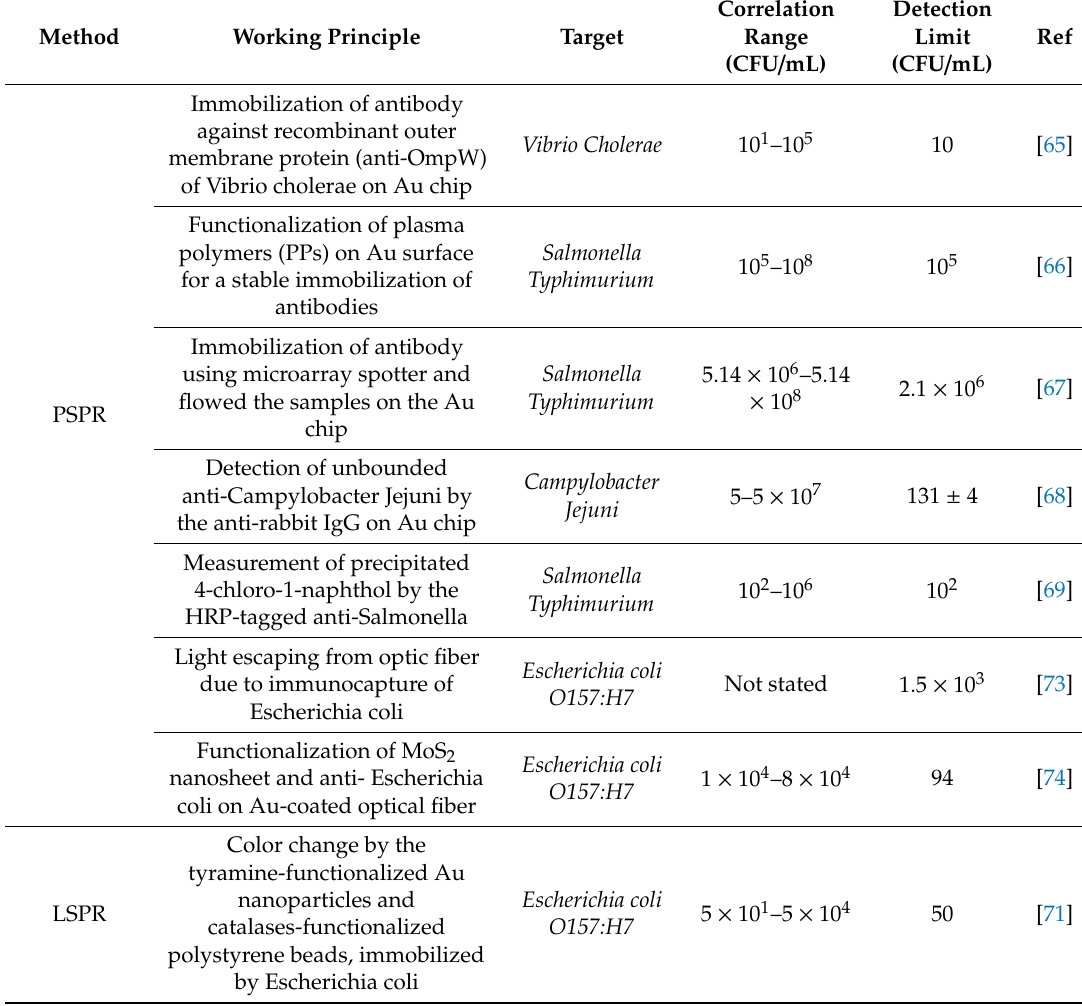
Figure 6. LSPR and optic fiber mediated SPR-based immunosensors for pathogenic microbe detection. ( a ) Colorimetric immunosensors with microfluidic device for the detection of E. coli O157 by aggregation of Au nanoparticles; ( b ) fiber optic SPR immunosensor based on MoS 2 nanosheet for the detection of E. coli. ( a ) Figure reproduced with permission from [71], © 2019 Elsevier, ( b ) Figure reproduced with permission from [74], © 2019 Elsevier. Table 3. Comparison of SPR and LSPR-based immunosensors for bacterial